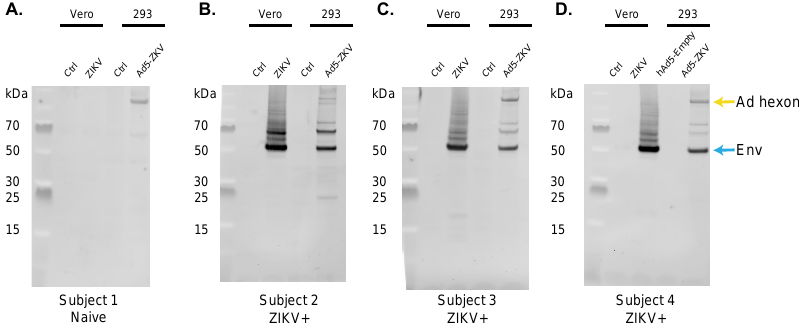
Figure 3. Recognition of hAd5-ZKV antigens by polyclonal human anti-ZIKV antibody response. Uninfected and ZIKV Vero cells, as well as uninfected and hAd5-ZKV-infected 293 cells, were probed with human serum from subjects that had a naturally acquired ZIKV infection, demonstrating recognition of ZIKV E antigens by the human immune response. ( A ) Serum from a flavivirus-naïve individual was used as a control, with staining for Ad5 hexon protein apparent. ( B )–( D ) Serum from three human positive subjects after 9–12 months after a ZIKV-positive test showed staining for E and hAd5 hexons.